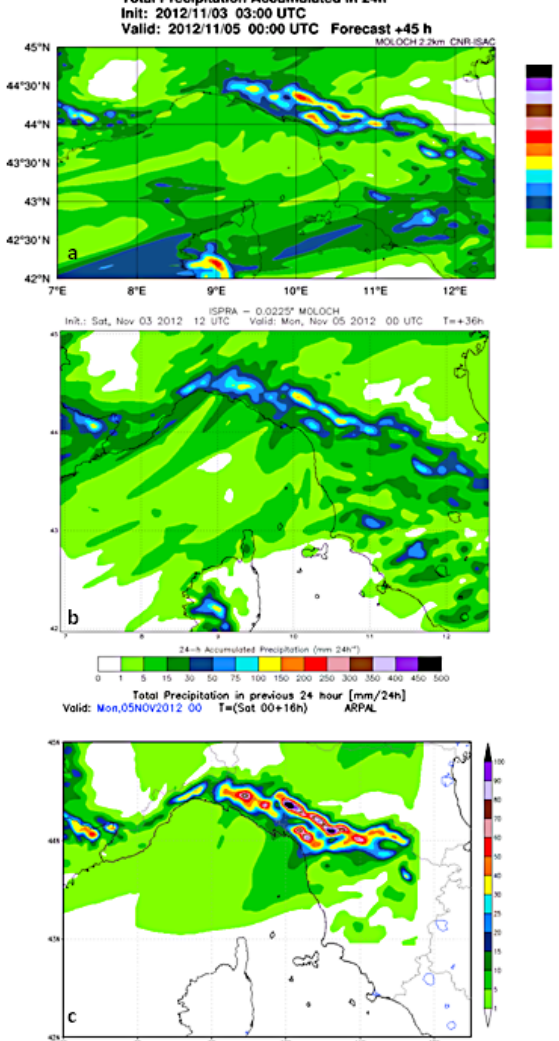
Figure 24. 24h accumulated precipitation at 00:00UTC, 5 Novem- ber 2012, forecast by different operational chains using MOLOCH: (a) CNR-ISAC at 2.3km starting at 03:00UTC on 3 November; (b) ISPRA at 2.5km starting at 12:00UTC on 3 November; (c) ARPAL at 2.3km, starting at 00:00UTC on 3 November